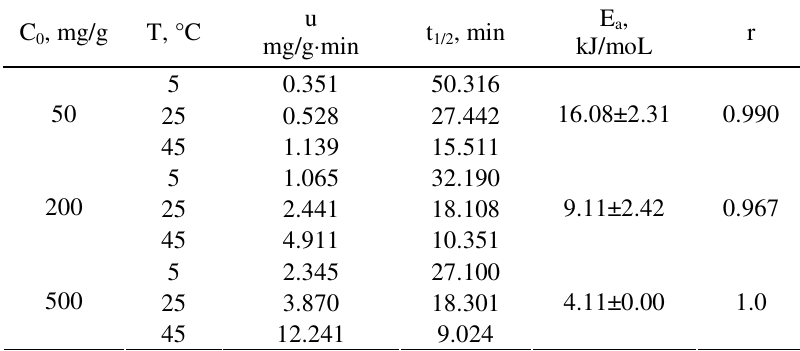
Table 8 . Kinetic parameters for the second order adsorption model of PEG